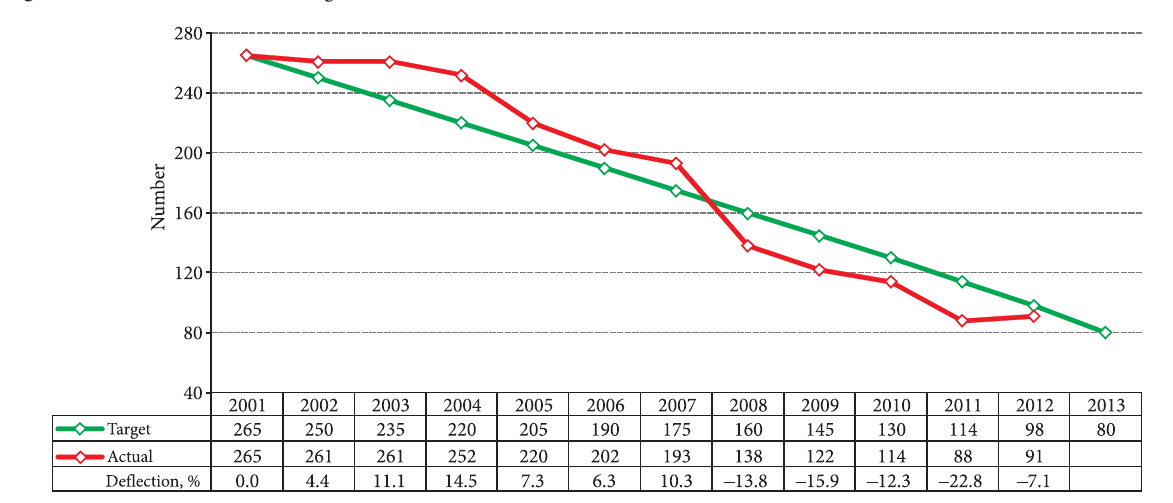
Fig. 8. Number of killed and the target in 2001–2012